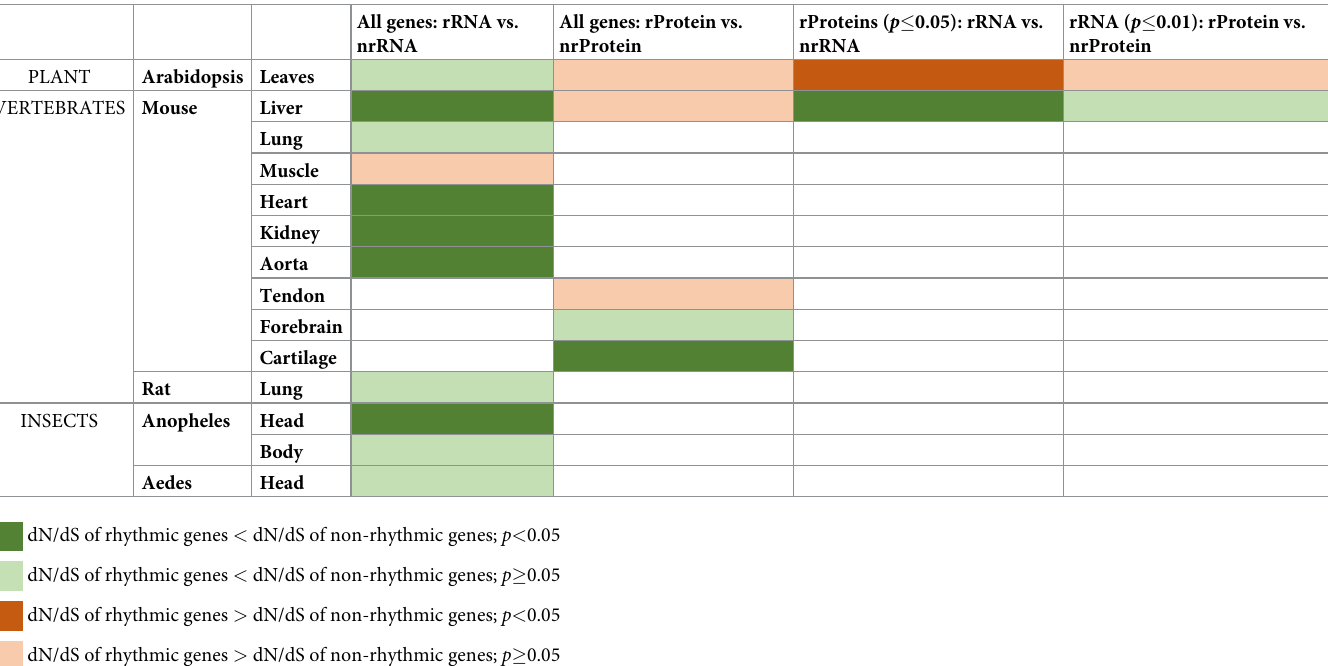
Table 2. Simplified table showing the results of the Welch two sample t-test testing the hypothesis that dN/dS ratio is equal between rhythmic versus non-rhythmic transcripts (a), or proteins (b), or between rhythmic versus non-rhythmic transcripts among rhythmic proteins (c), and between rhythmic versus non-rhythmic pro- teins among genes with rhythmic transcripts (d). In S8 Table, triangles give the result of the Welch two sample t-test without controlling for the effect of gene expression level. Complete results are provided in S6 Table. All genes: rRNA vs.